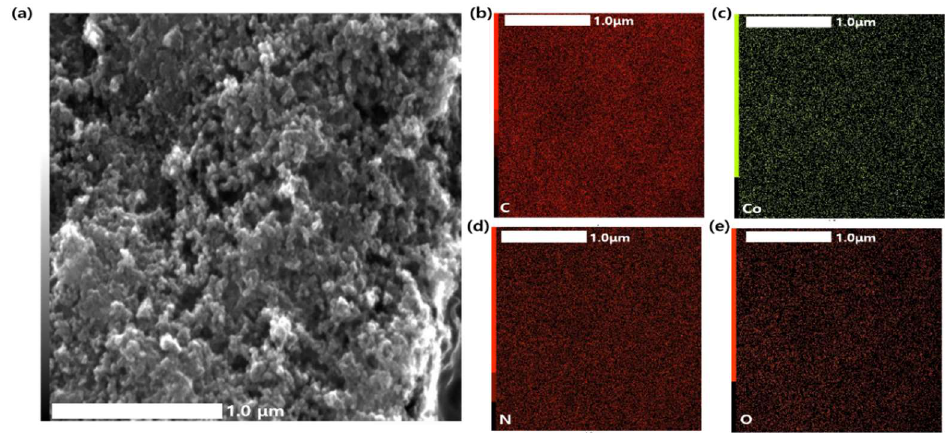
Figure 2. SEM images of the ( a ) quaternary-N and amino-N-doped carbon (Q-A/Co), ( b ) amino-N- doped carbon (A/Co), and ( c ) quaternary-N-doped carbon (Q/Co) catalysts.